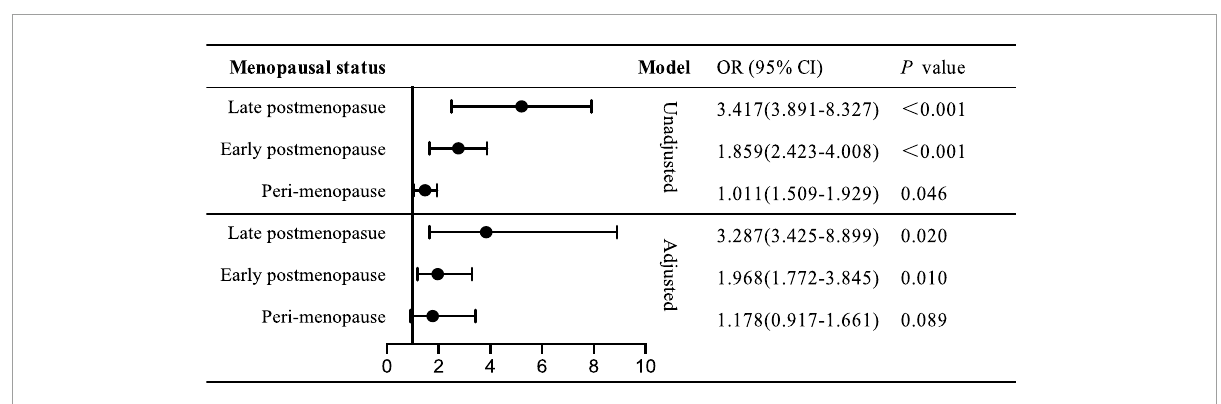
FIGURE2 Odds ratio of PSQI ≥ 8 for declining renal function stratified by menopause